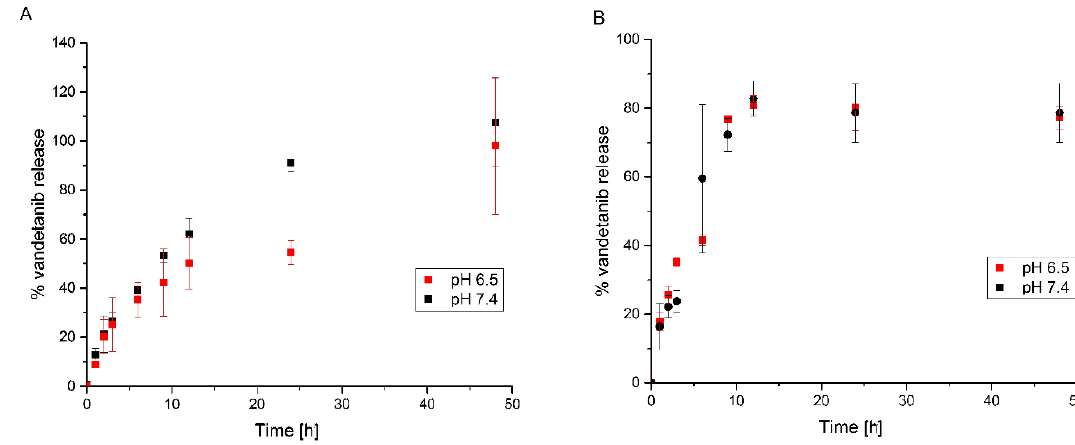
Figure 4. The kinetics of Van release from: ( A ) ApoVan; ( B ) ApoVan prepared without using reversible dissociation of apoferritin at pH 6.5 and 7.4 at 37 °C. Values are mean ± SD from three independent experiments.